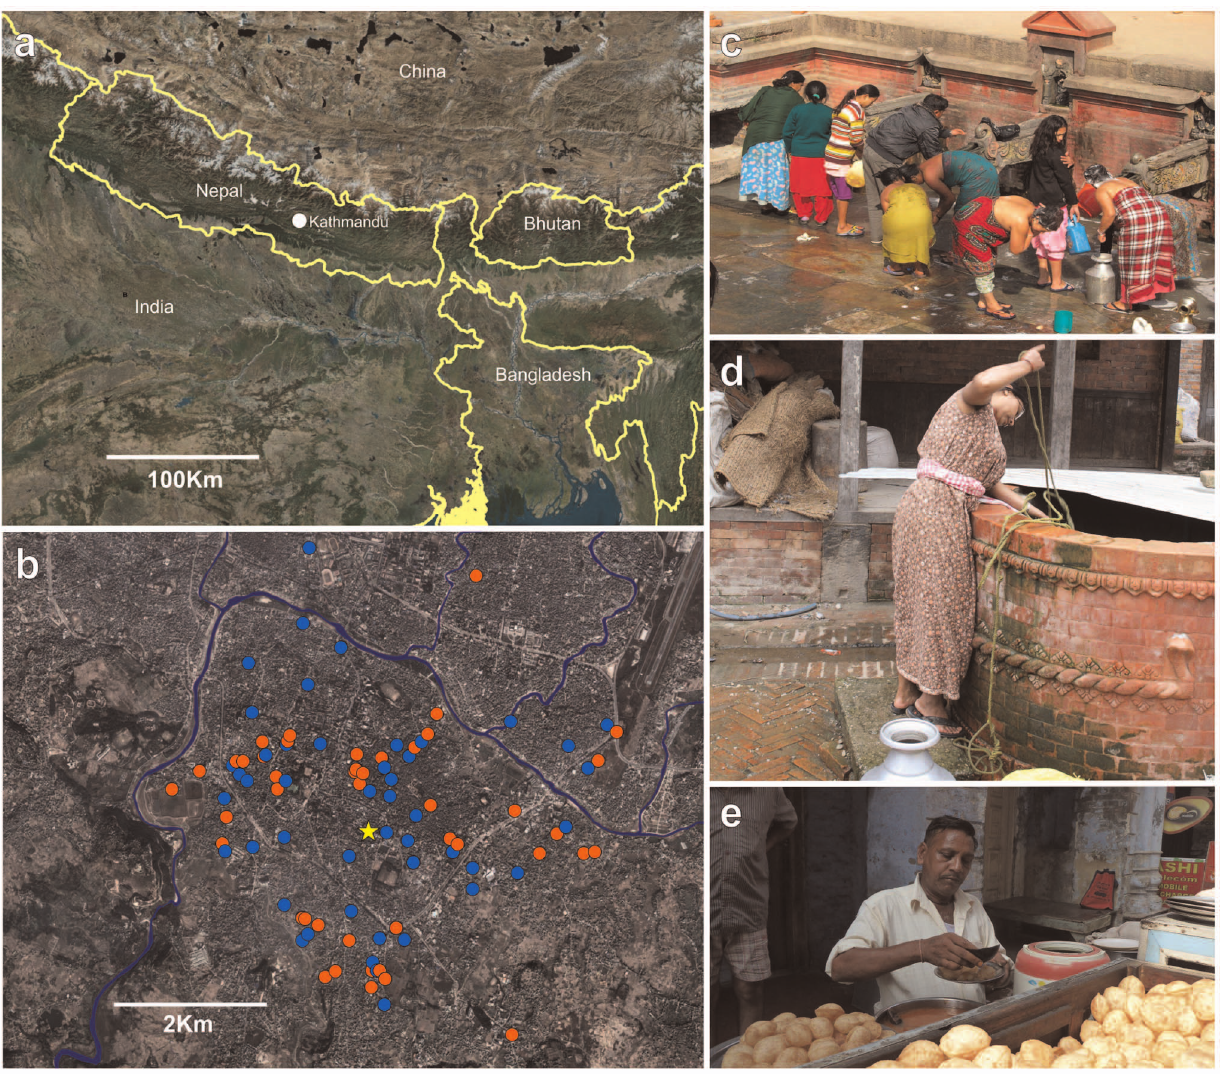
Figure 1. The location and the socioeconomics of Kathmandu. a) Map of southern Asia showing the location of Nepal and the capital city of Kathmandu; the location for the case/control investigation, in the context of neighboring countries b) Lalitpur, Kathmandu; the locale of the case control study, the locations of household of the cases are shown in red ( S. Typhi) and blue ( S. Paratyphi A), and the site of enrollment of the cases (Patan hospital) is shown by a yellow star. c) A typical municipal stone waterspout in the location of the enteric fever case/control investigation. d) A typical municipal sunken well in the location of the enteric fever case/control investigation. e) A local street food vendor preparing and selling pani